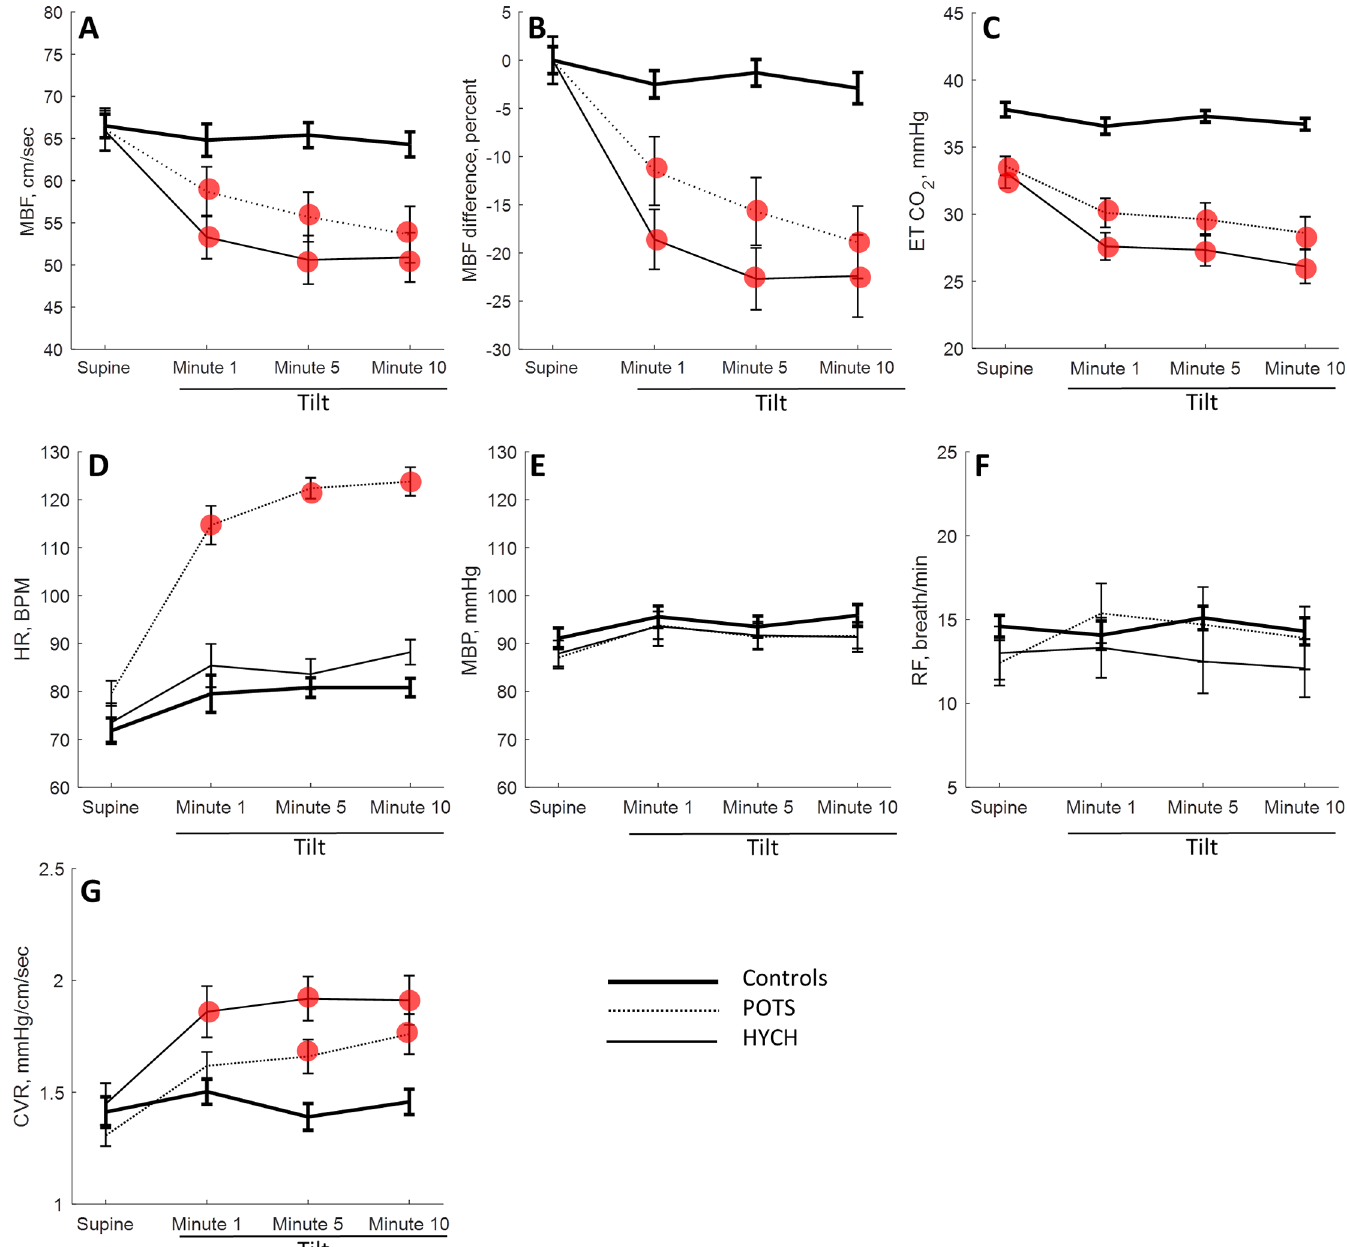
Fig 5. Comparison of HYCH, POTS and controls. The hemodynamic variables were analyzed during supine position and at the minute 1, 5 and 10 of the tilt. Red circle shows significance difference compared to controls. A. CBFv = mean blood flow velocity, B. CBFv difference = percent difference in CBFv compared to supine baseline; C. ET = end tidal CO 2 ; D. HR = heart rate, E. CVR = cerebrovascular resistance, F. MBP = mean blood pressure;, G. RF = respiratory